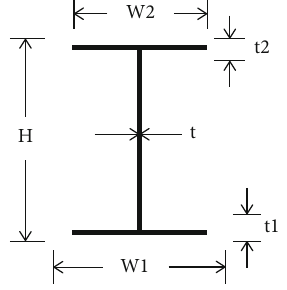
Figure 4: A cross-section size of the